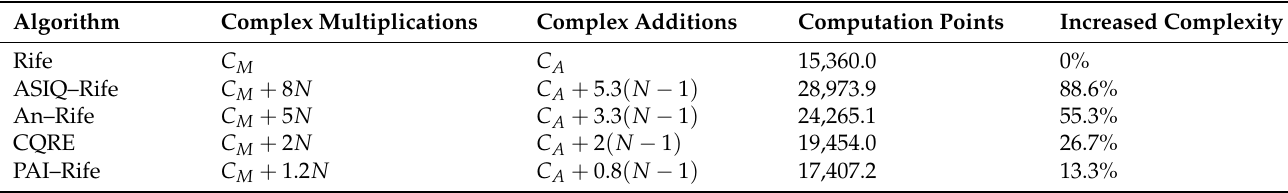
Table 2. Complexity of different Rife algorithms ( N = 1024